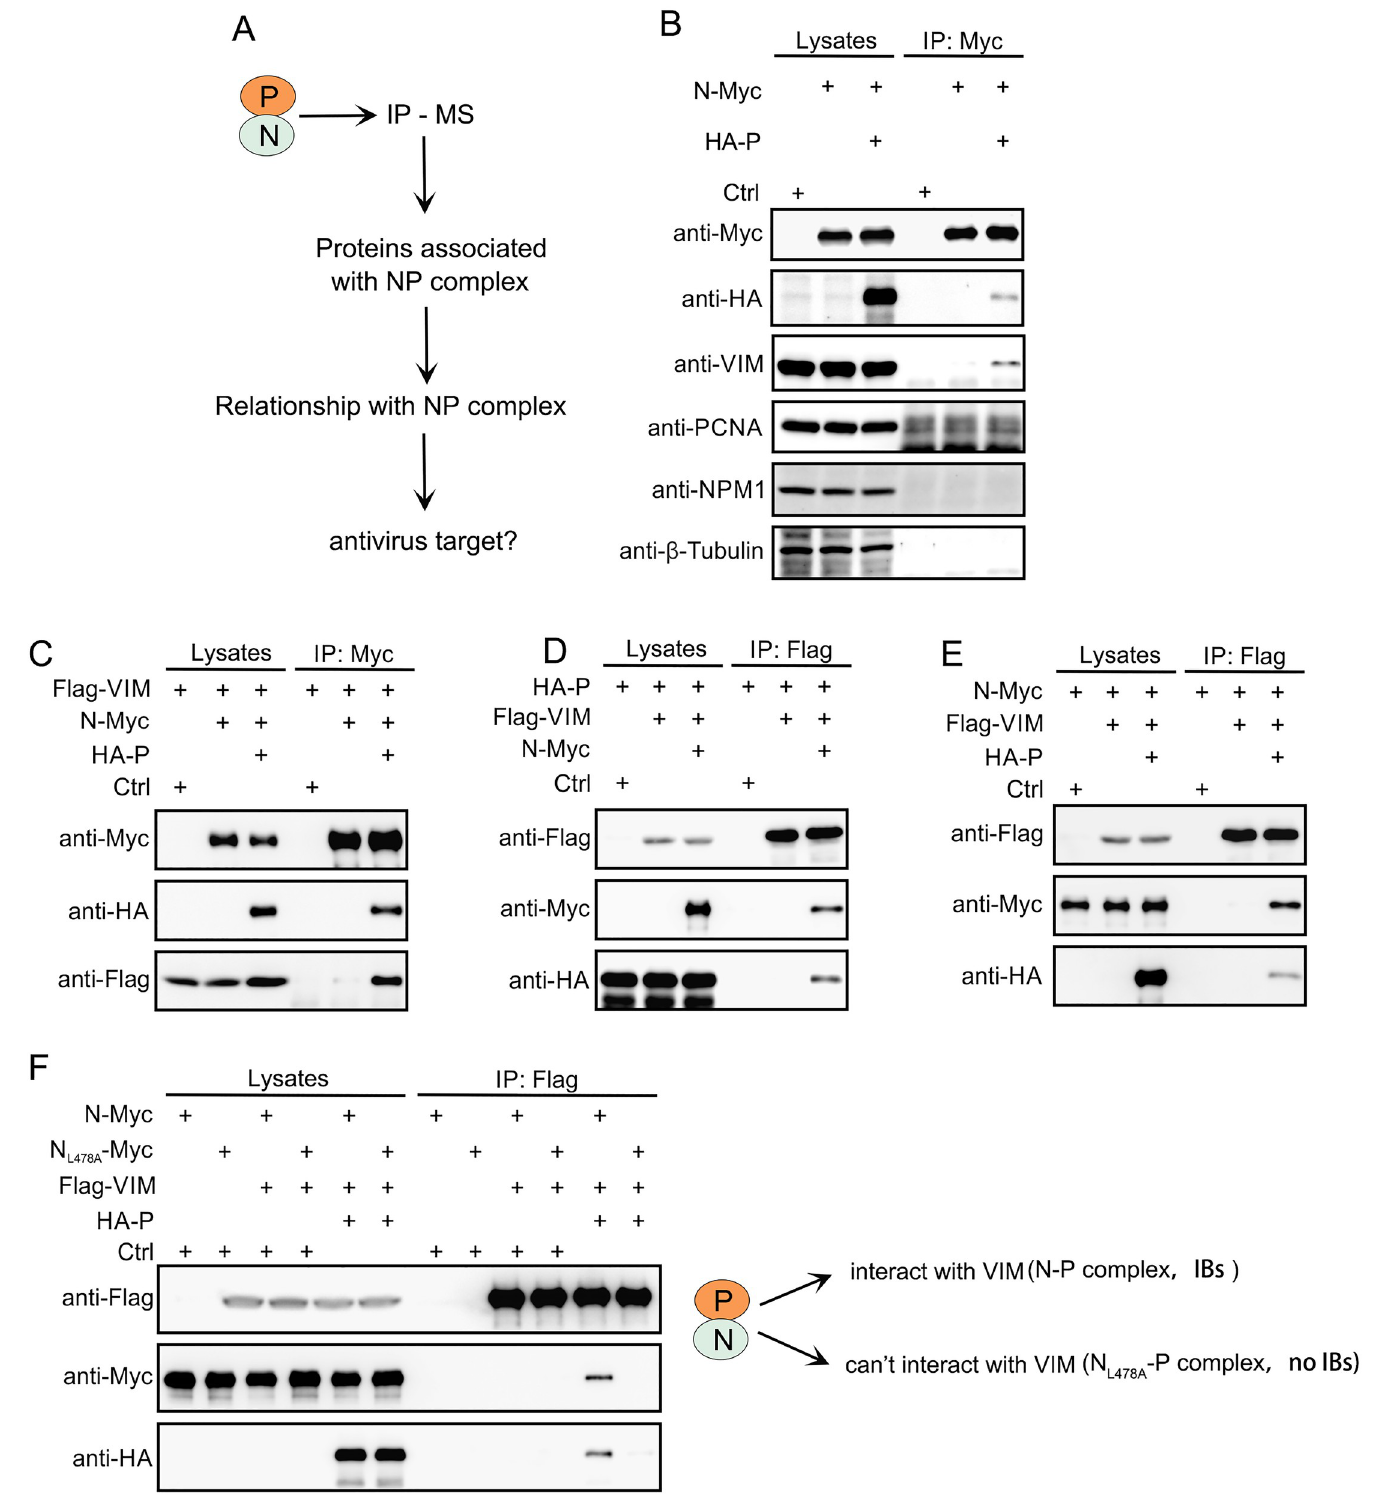
Fig 1. VIM specifically interacts with HPIV3 N–P complex. (A) Experimental design flow chart. HPIV3 N–P complex expressed in HEK293T cells was immunoprecipitated (IP) using anti-c-Myc tag affinity gel. The bands of interest in silver staining were isolated and analyzed using mass spectrometry (MS).